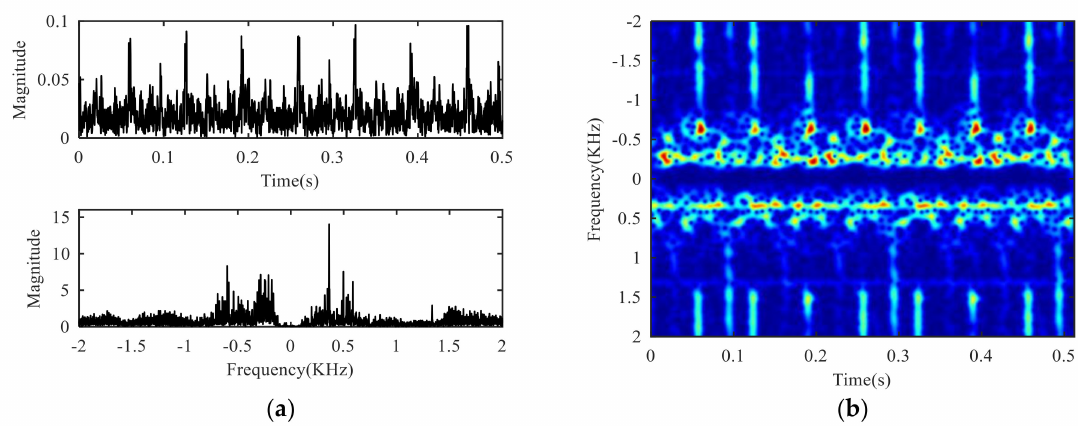
Figure 9. Reconstruction signal: ( a ) Time domain and frequency domain, ( b ) time-frequency domain.